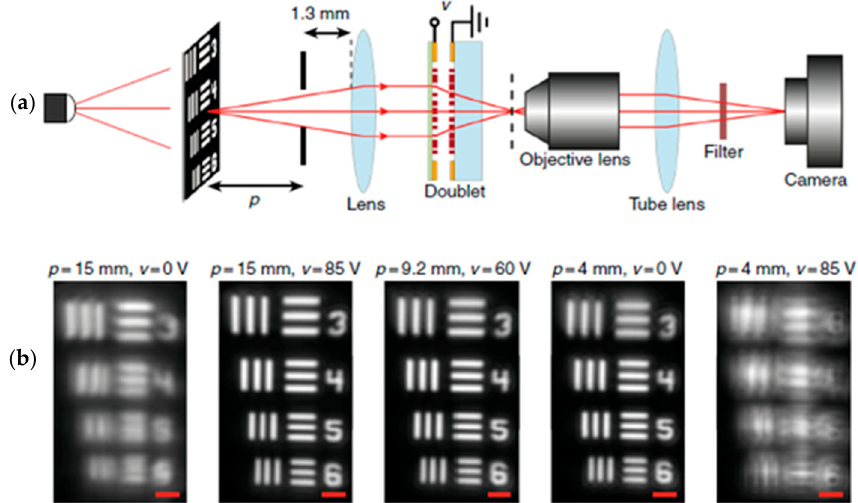
Figure 10. Imaging with the tunable doublet. ( a ) Schematic illustration of the imaging setup using a regular glass lens and the tunable doublet. The image formed by the doublet is magnified and re-imaged using a custom-built microscope with a × 55 magnification onto an image sensor. ( b ) Imaging results, showing the tuning of the imaging distance of the doublet and glass lens combination with applied voltage. By applying 85 V across the device, the imaging distance increases from 4 to 15 mm. The scale bars are 10 µm. (Reproduced from [49] with permission.)